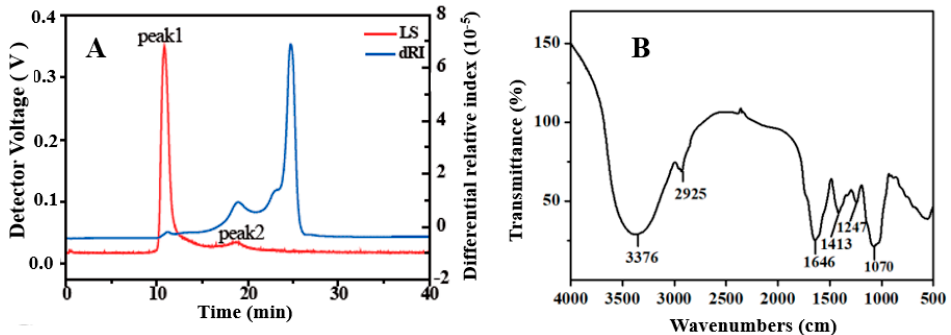
Figure 2. The molecular weight ( A ) and FITR spectrum ( B ) of EHPs.